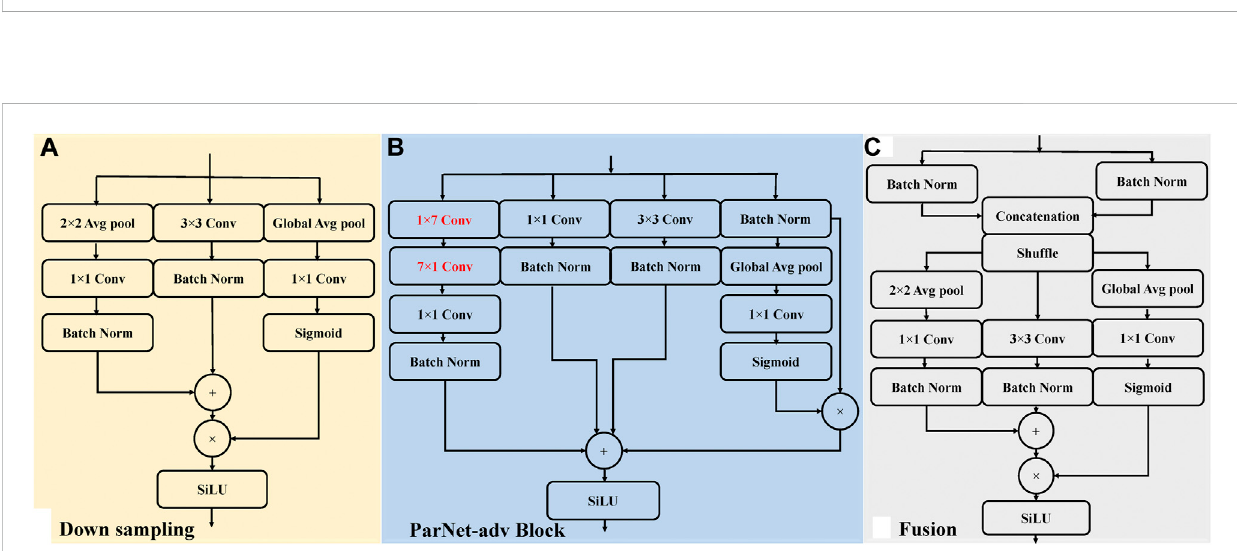
FIGURE 3 The sub-networks architectureoftheParNet-adv model, includingParNet-adv Block, Downsampling,and Fusion. Conv,convolutional layer;Batch Norm,batchnormalizationlayers;GlobalAvgpool,globalaveragepoolinglayer;Avgpool,intermediatepoolinglayer;SiLU,sigmoidlinearunitactivation. (A) An illustration of the Downsampling block. (B) An illustration of the ParNet-adv block with the key design of 1 × 7 and 7 × 1 asymmetric convolutions. (C) An illustration of the Fusion